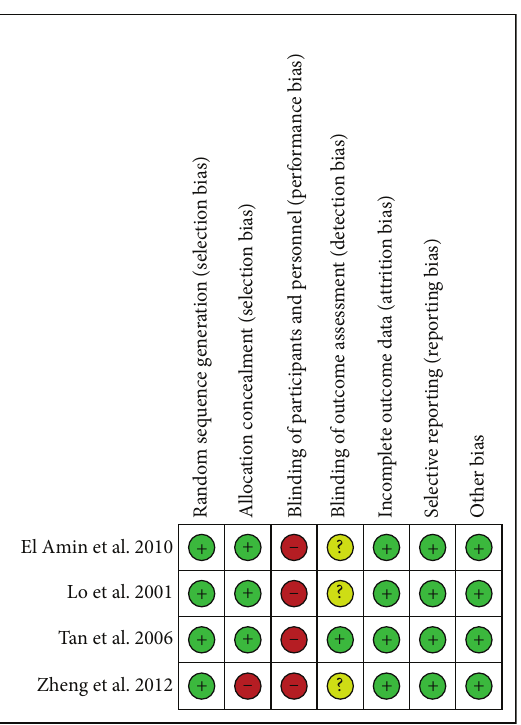
Figure 2: Risk of bias assessment for RCTs. Reviewers’ judgment of the risk of bias for each item for each of the four RCTs included in the meta-analysis. Green-colored symbol corresponds to low risk of bias, yellow corresponds to unclear risk of bias, and red corresponds to high risk of